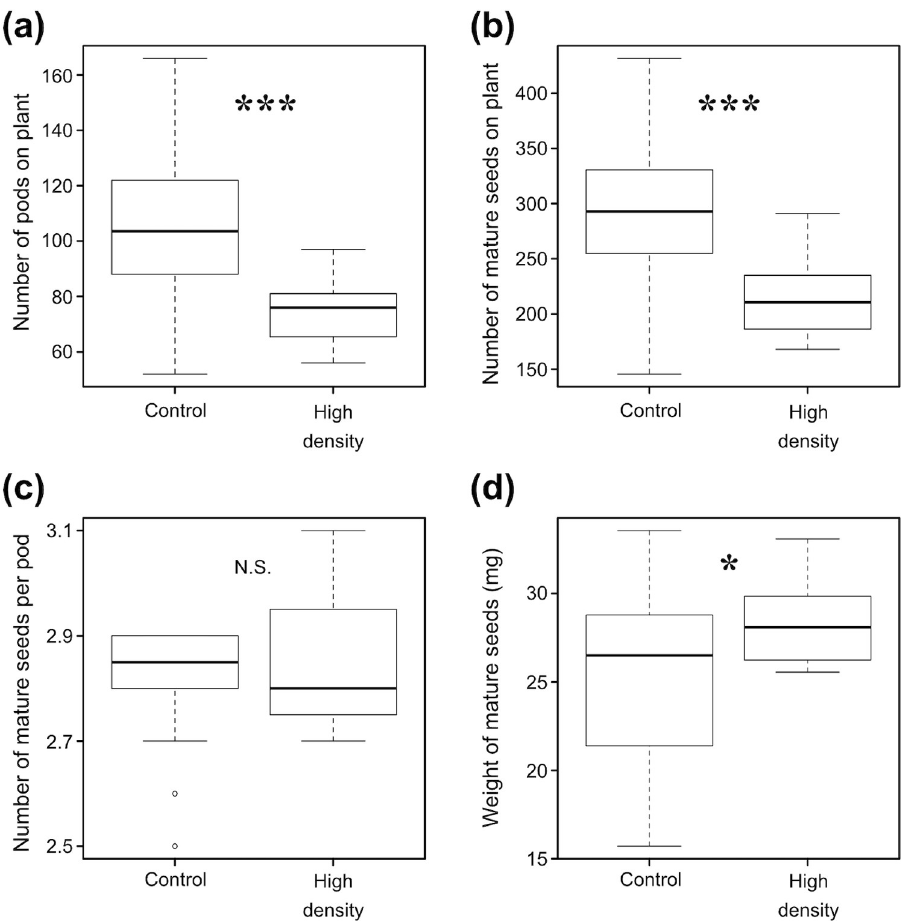
Fig 5. Pod and seed production in the progeny of Riptortus pedestris infested (high density) and non-infested (control) Glycine soja . (a) Number of pods on each plant. (b) Number of mature seeds on each plant. (c) Number of mature seeds per pod. (d) Mean weight of mature seeds. Asterisks indicate significant differences between treatments (GLM; � p < 0.05, ��� p < 0.001; N.S., p > 0.05).